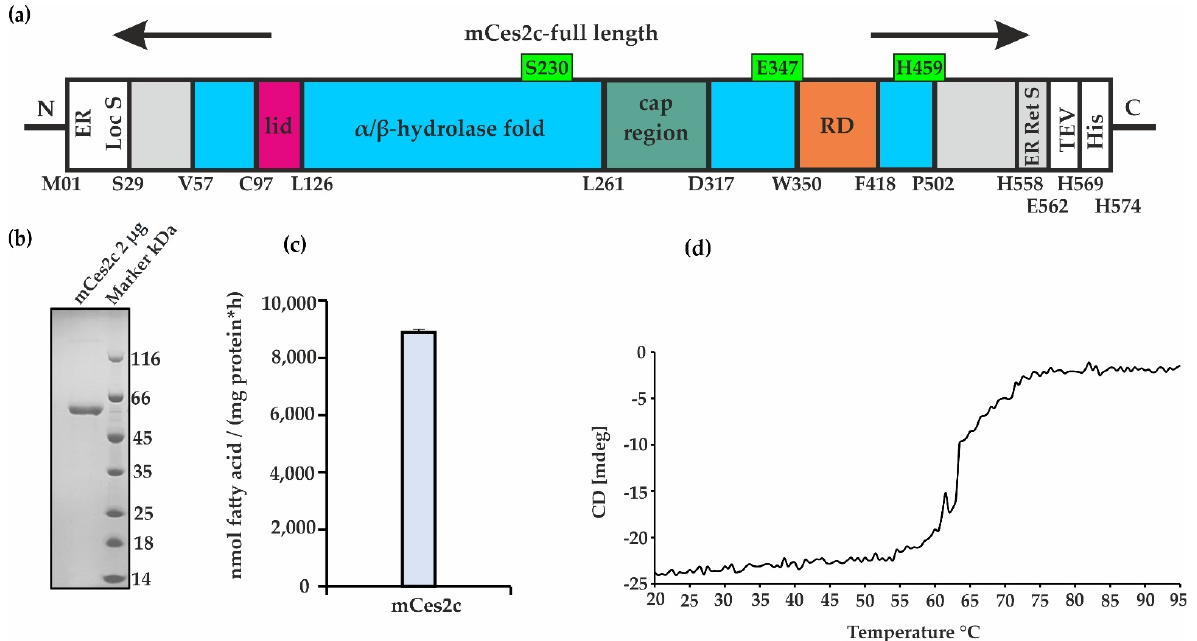
Figure 1. mCes2c expression, purification, hydrolytic activity, and thermal stability. ( a ) Scheme of mCes2c used in this study. The lid is shown in pink, the α / β‐ hydrolase core is indicated in blue, the cap region in teal, and the regulatory domain (RD) in orange. Catalytic triad residues (S230, E347, H459) are indicated in green. The gray parts indicate N ‐ and C ‐ terminal extensions of the classic α / β‐ hydrolase core and the endoplasmic reticulum retention signal (ER Ret S) visible in the crystal structure (PDB 8AXC). The white parts represent the endoplasmic reticulum localization signal (ER Loc S), the TEV ‐ cleavage site, and the C ‐ terminal 6xHis tag. ( b ) SDS ‐ PAGE of purified mCes2c. ( c ) Neutral lipid hydrolase activity assays were performed with purified mCes2c upon in ‐ cubation with monoolein. The released fatty acids were monitored as readout of hydrolysis. ( d ) Thermal unfolding of mCes2c monitored with CD spectroscopy.